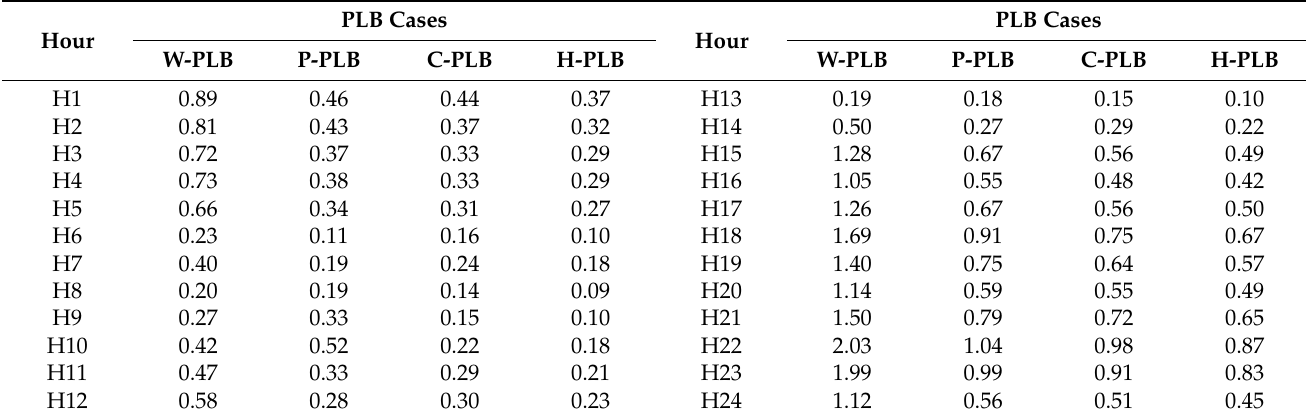
Table 9. The hourly total power losses calculated for all analysed cases, in (kW).